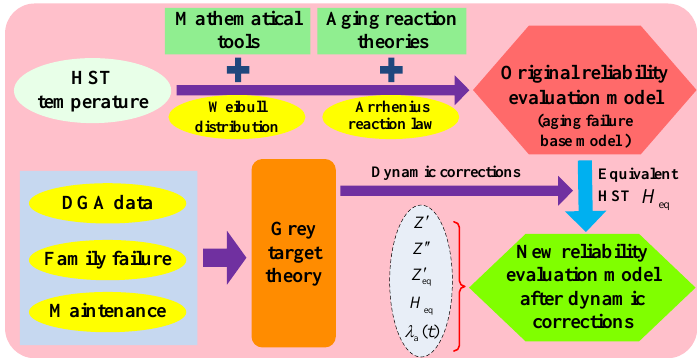
Figure 4. Framework of the final reliability assessment model for the transformer oil-paper insulation system (TOPIS).